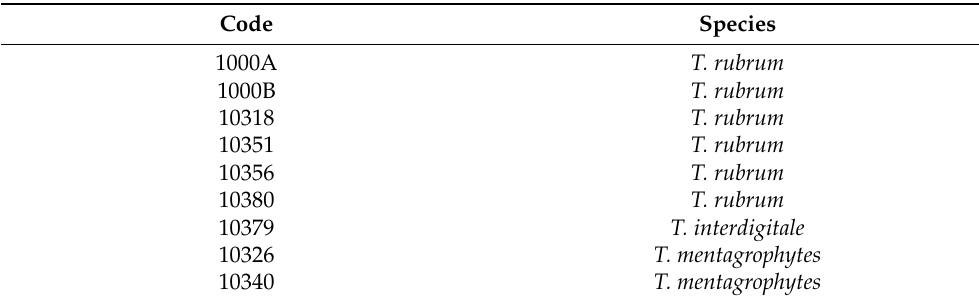
Figure 1. Percentage of etiological agents of onychomycosis isolated at the Mycology Laboratory of DSTA (UNIPV, Italy). Filamentous fungi are indicated with blue bars, whereas yeasts with yel- low bars. Table 2. Trichophyton species identified with corresponding codes. (Medical mycology strain col- lection, MicUNIPV, DSTA, University of Pavia).